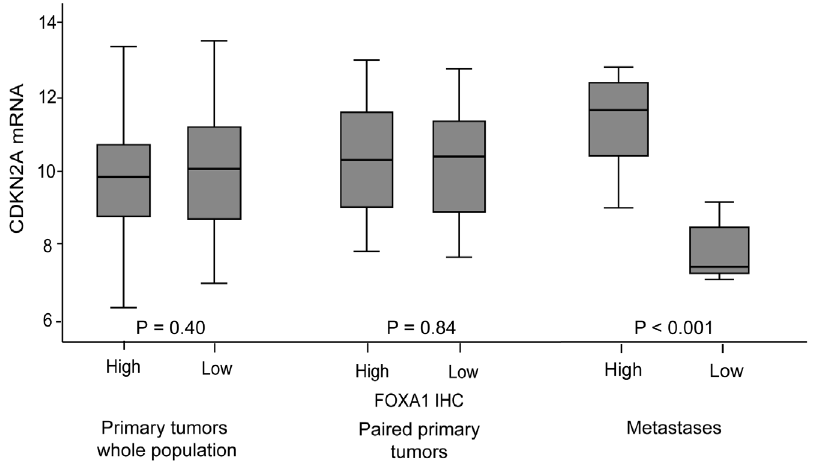
Figure 4. FOXA1 and CDKN2A. Protein expression of FOXA1 is significantly associated with CDKN2A mRNA expression in metastases, but not in primary tumors.